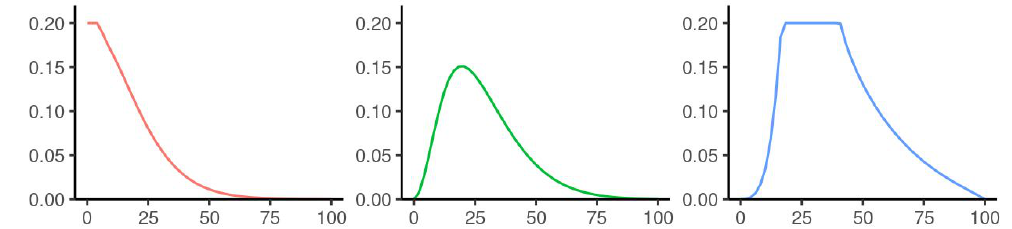
Figure 8. Experiment 1. The structure of the optimal treatment policies u i ( t ) , i = 1,2,3. Table 1. Parameters used for simulations in